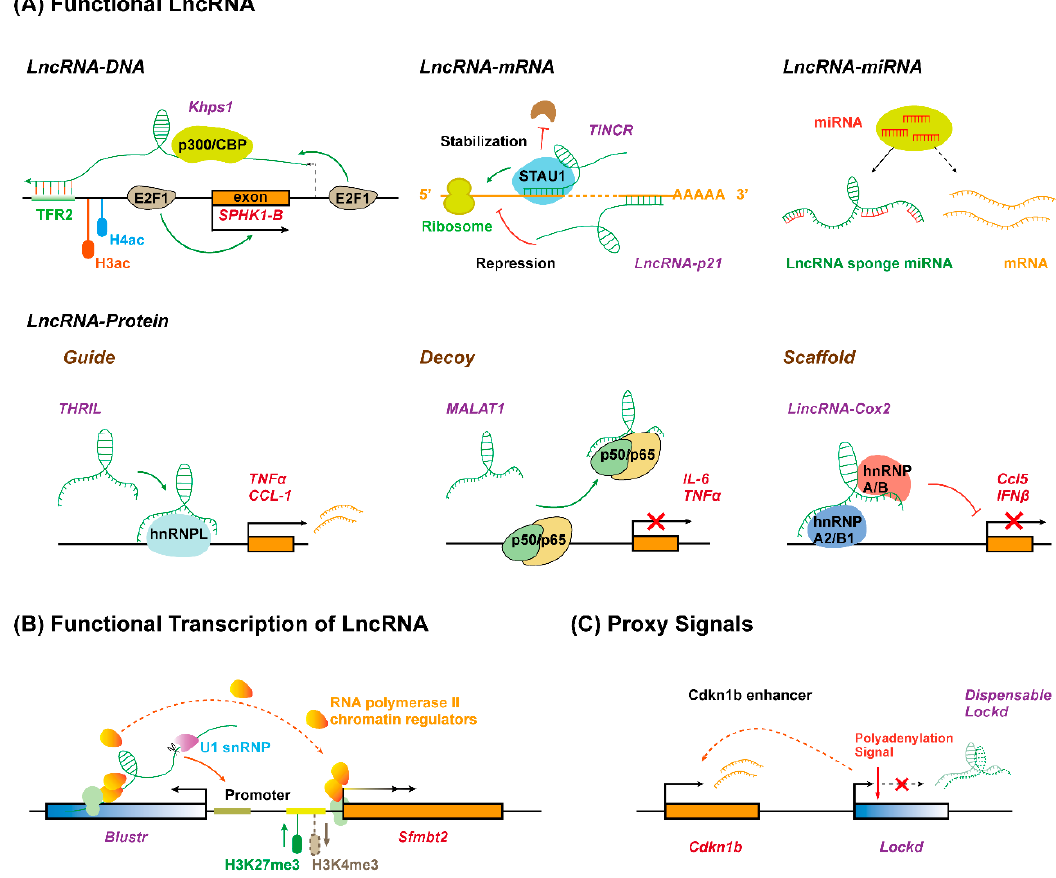
Figure 2. Long non-coding RNAs function as versatile transcriptional regulators in three different manners. ( A ) LncRNA molecule is functional due to its specific sequence interacting with DNA, RNA, or protein. LncRNA ( Khps1 ) tethers to DNA via formatting triplex with specific sequence and guides chromatin regulators to target gene ( SPHK1-B ) promoter. LncRNA interacts with target mRNA by base-pairing to repress ( lncRNA-p21 ) or enhance ( TINCR ) translation. LncRNA sponges miRNA to inhibit degradation and translation repression of mRNA. LncRNA interacts with specific proteins to regulate target gene expression by acting as a guide ( THRIL ), decoy ( MALAT1 ), or scaffold ( lincRNA-Cox2 ). ( B ) The act of lncRNA transcription is functional. The transcription and promoter-proximal splicing process of lncRNA ( Blustr ) alter the chromatin state and ensure RNA polymerase elongation at the promoter of target gene ( Sfmbt2 ). ( C ) LncRNA acts as proxy signal for cis-regulatory elements. The 5 ′ region or promoter of lncRNA ( Lockd ) contains an enhancer for the neighboring genes ( Cdkn1b ). TFR, triplex-forming regions.